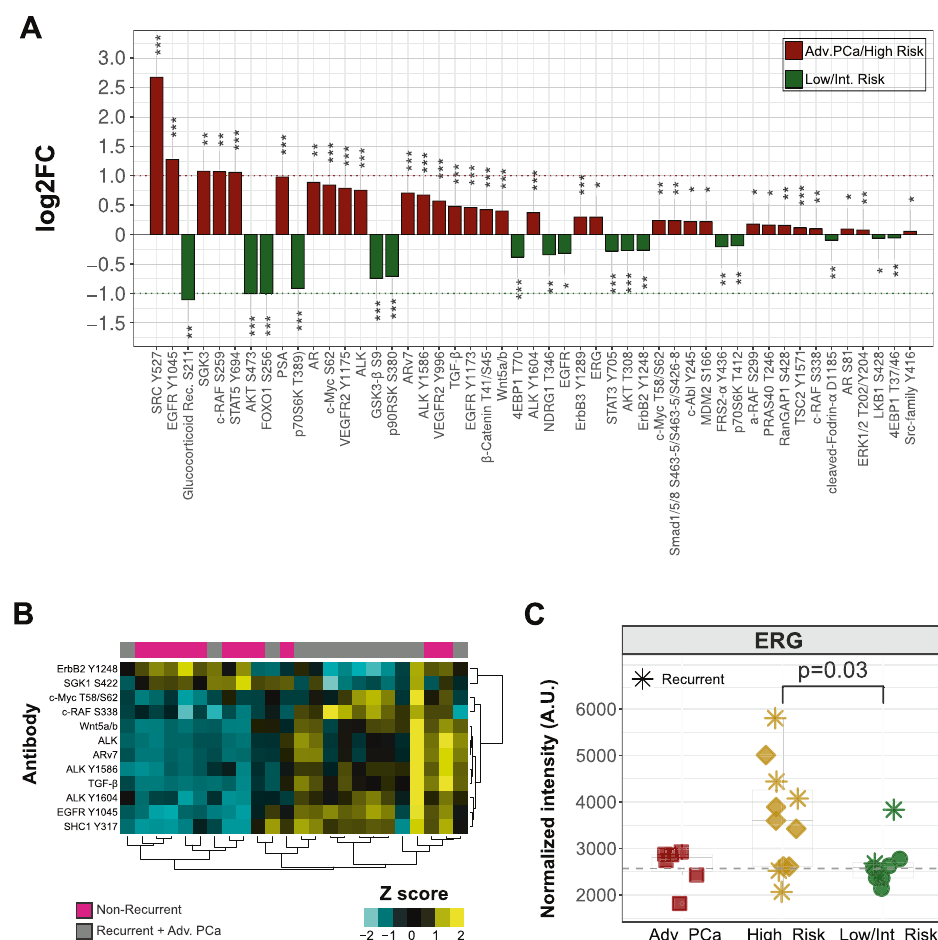
Fig. 5 Analysis of EV-based prognostic RPPA biomarkers. A Bar chart of log2 fold-change (log2FC) of grouped high-risk and advanced PCa (red) versus low-/intermediate-risk (green) patients for all signi fi cantly different RPPA endpoints analyzed by Wilcoxon rank-sum test. Statistical signi fi cance reported for each bar is coded with asterisk(s) based on the level of signi fi cance (* p < = 0.05, ** p < = 0.01, *** p < = 0.001). B Two- way unsupervised hierarchical clustering of the 13 signi fi cantly different ( p < = 0.05) RPPA endpoints emerging from statistical comparison of non-recurrent (pink, n = 11) and grouped recurrent and advanced tumor (gray, n = 13) EV samples. One sample was excluded due to lacking follow-up information. C Scatterplots of ERG expression resulting from comparison of low/intermediate-, high-risk and advanced (Adv. PCa) tumors by RPPA analysis. Recurrent patients were indicated by an asterisk (*). The plots represent distribution of RPPA intensity values, and the line indicates an arbitrary baseline. Statistical comparisons were performed as described in the methods